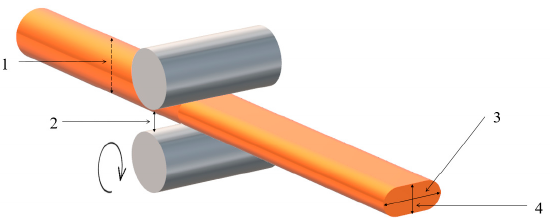
Figure 14. Wire flattening model: 1-Original line diameter; 2-Roller spacing; 3-New line width; 4-New line height.